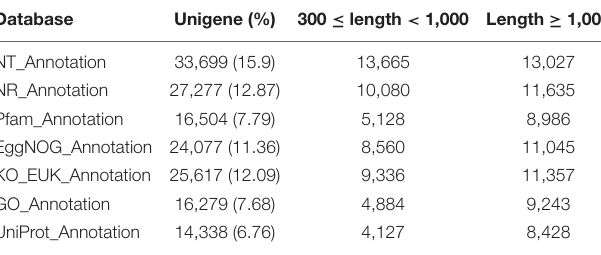
TABLE 1 | Statistics of annotation analysis of